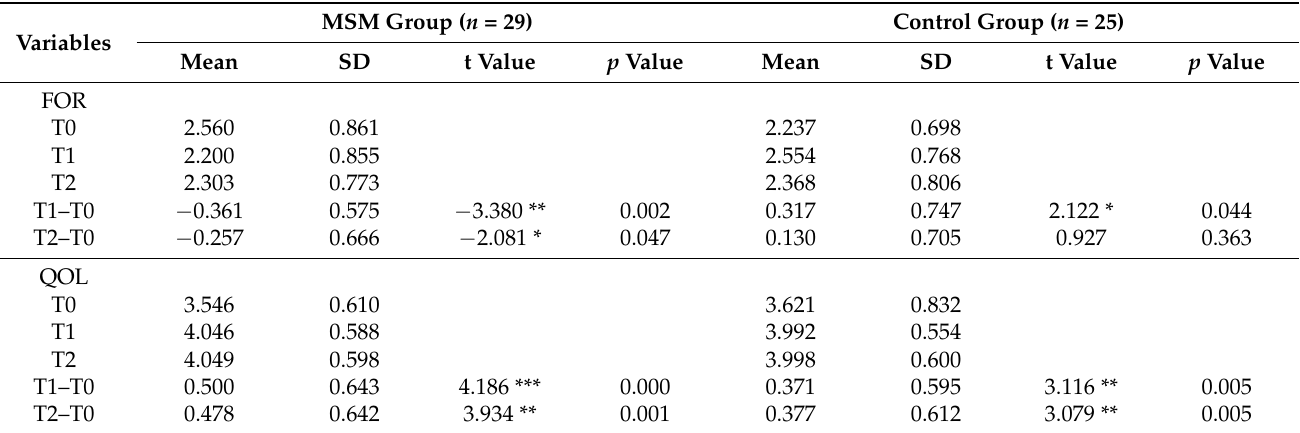
Table 2. Paired sample t tests of outcome variables over time for within-group analysis.